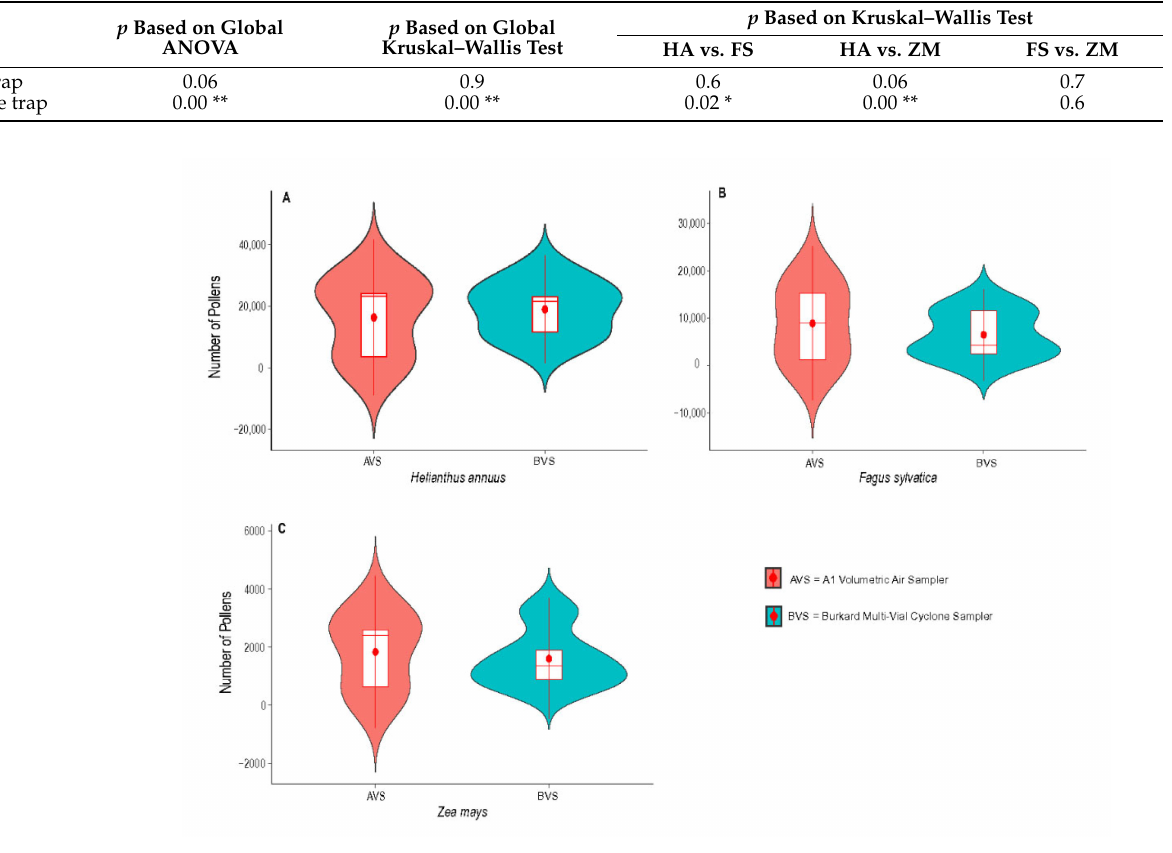
Figure 1. Pairwise comparison of pollens inhaled by the A1 volumetric air sampler and the Burkard Multi-Vial Cyclone Sampler for ( A ) Helianthus annuus , ( B ) Fagus sylvatica and ( C ) Zea mays